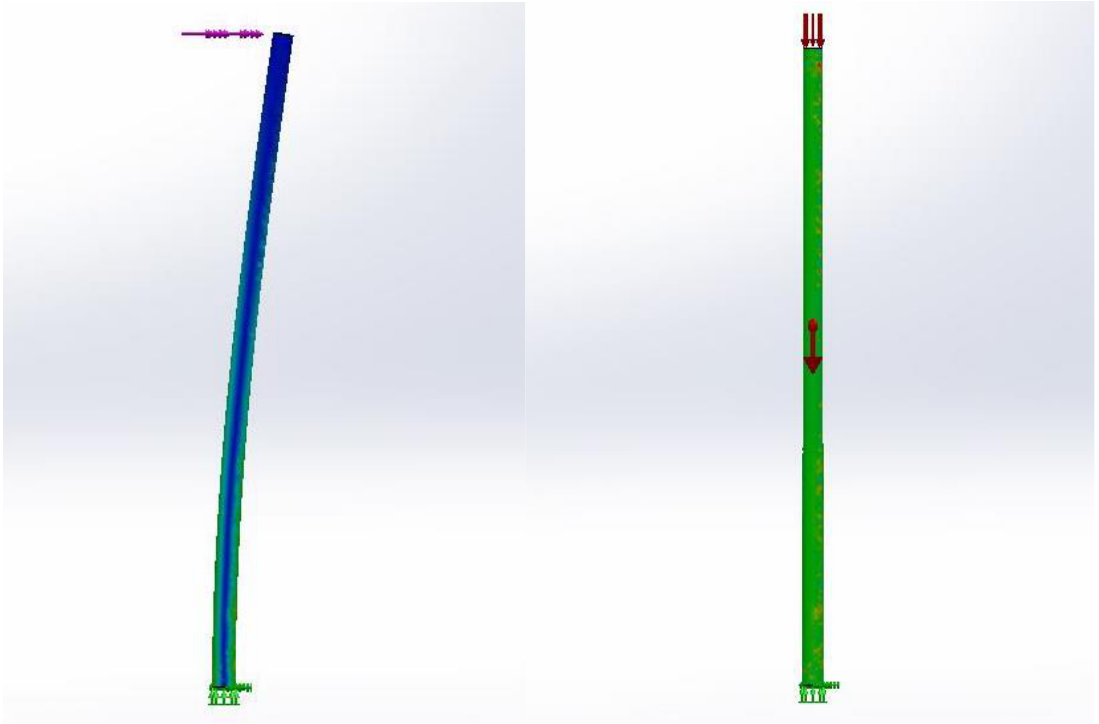
Figure 5. Defined forces: wind force on tower (left) and parts weights (right)